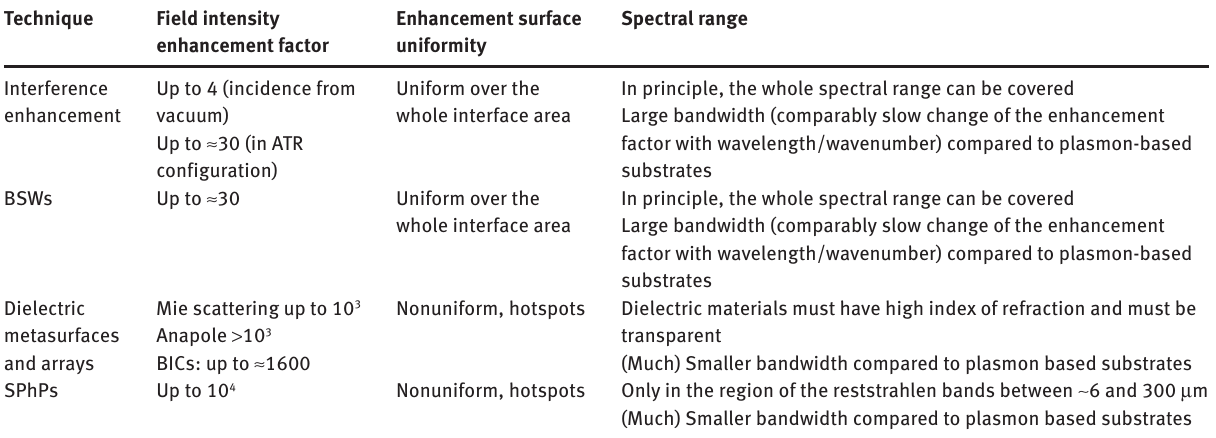
Table 1: Overview of the covered techniques and their evaluation in terms of field intensity enhancement factor, enhancement surface uniformity, spectral coverage, and